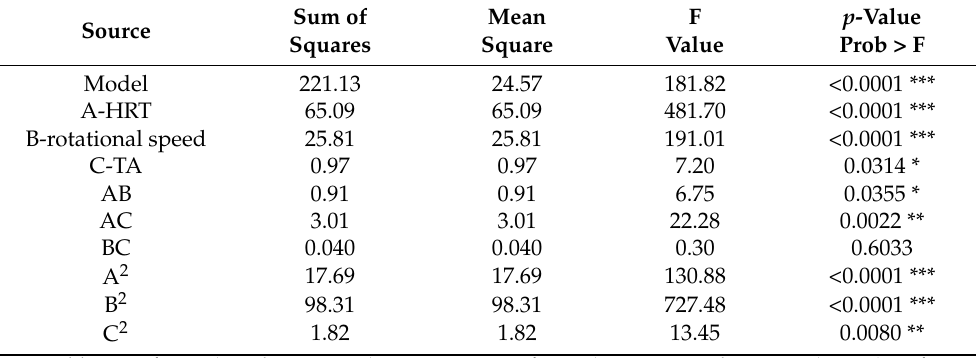
Table 2. Results of the regression analysis of the Box–Behnken experimental design. Sum of Source Squares